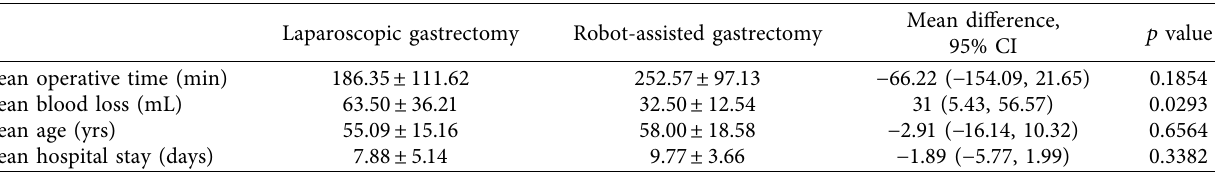
Table 5: Comparison of mean operative time, intraoperative blood loss, age of the patients, and hospital stay duration for Laparoscopic and robot-assisted gastrectomy in SIT patients.